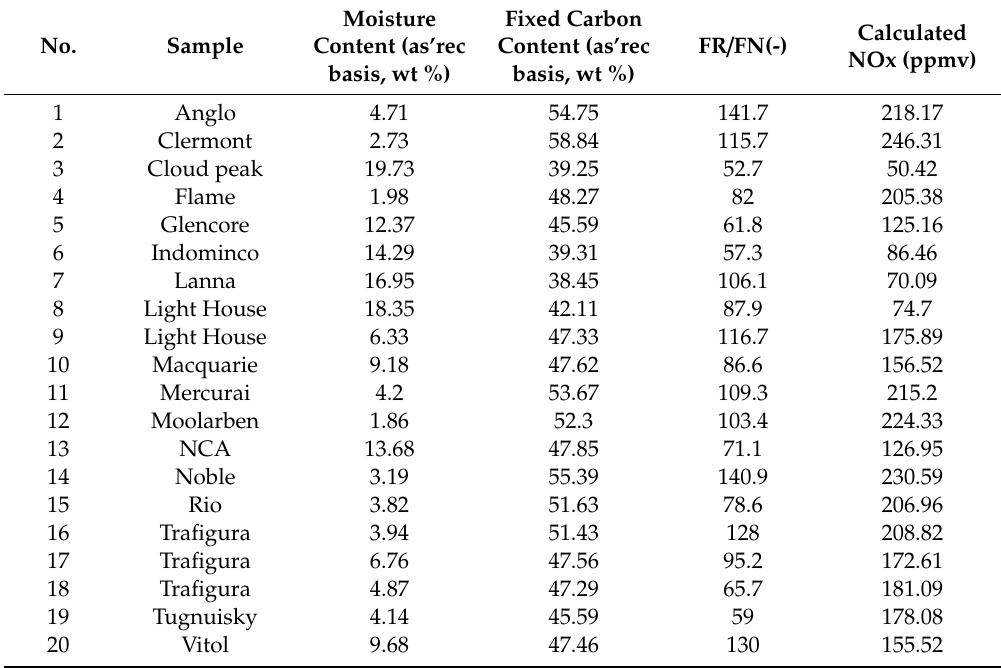
Table 3. Fuel sample properties to the NOx emission